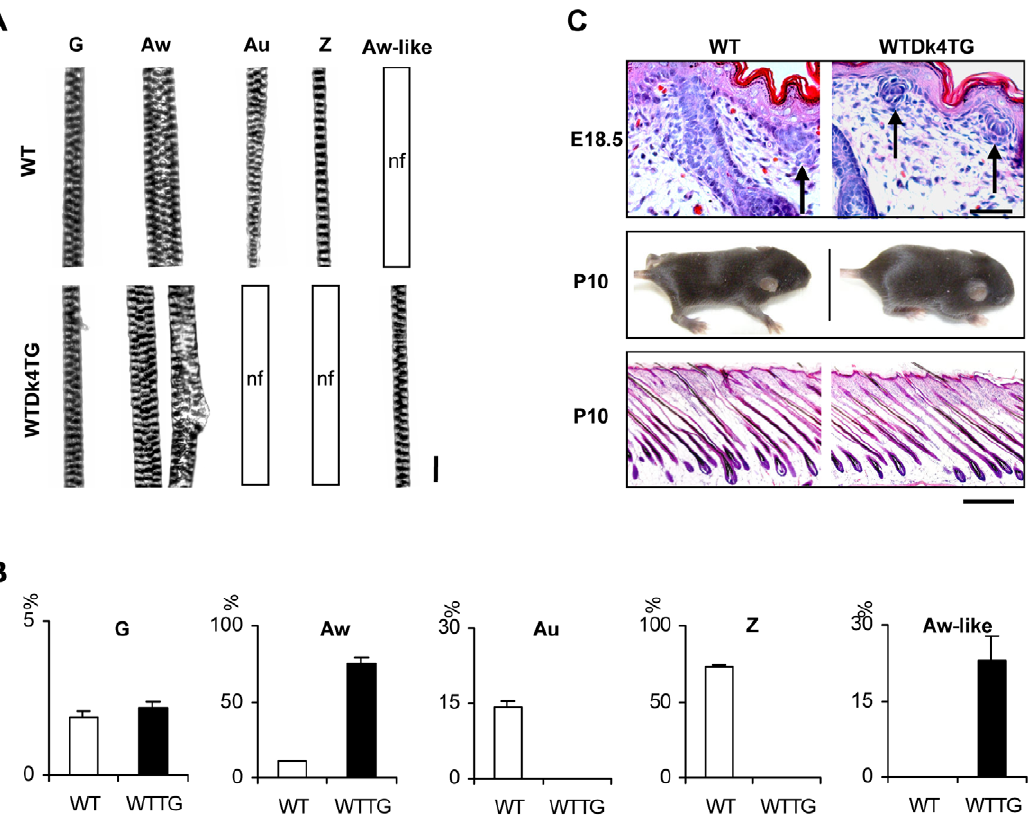
Figure 2. Secondary, but not primary, hairs are severely malformed in WTDk4TG mice. A, Morphology of each hair subtype is shown. In WTDk4TG mice, primary guard hair (G) was indistinguishable from that of WT controls, but awl hair (Aw) was slightly thinner or structurally aberrant, and auchen (Au) and zigzag (Z) hairs were absent. A thin awl-like abnormal hair (Aw-like) was formed in WTDk4TG mice. nf: not found. Scale bar, 200 m m. B, Quantitative analyses of hair subtypes. Primary hair numbers in WTDk4TG mice were comparable to WT controls. Awl hair numbers were significantly increased, auchen and zigzag hairs were absent, and awl-like abnormal hairs were newly formed in Dkk4 transgenic mice. C, Auchen/ zigzag hair follicle germs were formed at E18.5 both in WT and WTDk4TG mice (arrows in upper panels). The density of the hair coat in WTDk4TG mice was indistinguishable from that of WT littermates at P10 (middle panels). Comparable follicle numbers between WTDk4TG and WT mice at P10 were observed in histological analyses (lower panels). Scale bars, upper panels, 400 m m; lower panels, 1000 m